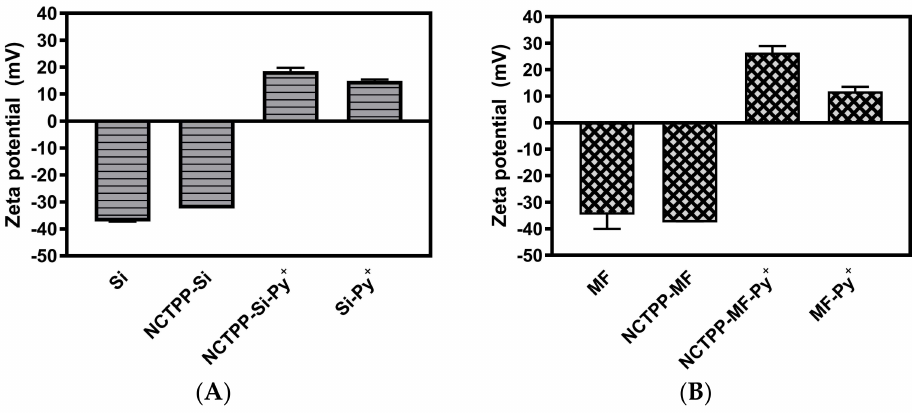
Figure 5. Zeta potential values of Si ( A ) and MF ( B ) and the corresponding organic-inorganic